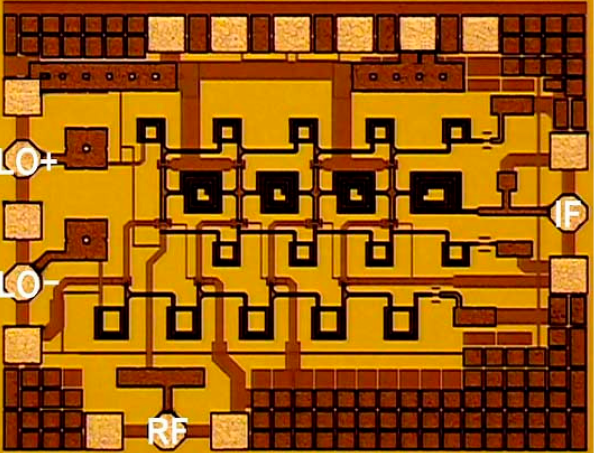
Figure 10. Chip photograph of the distributed mixer with area 0.92 mm × 0.72 mm